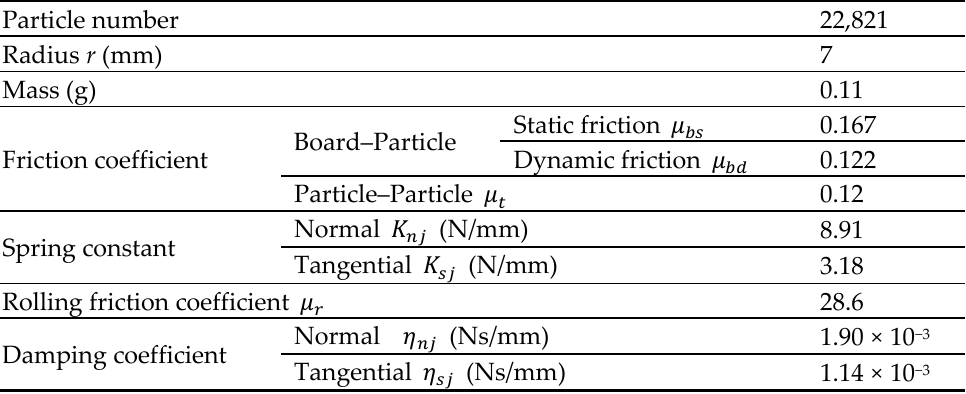
Figure 8. Identification test for the distinct element method (DEM) parameters. Table 2. Parameters for DEM simulation.